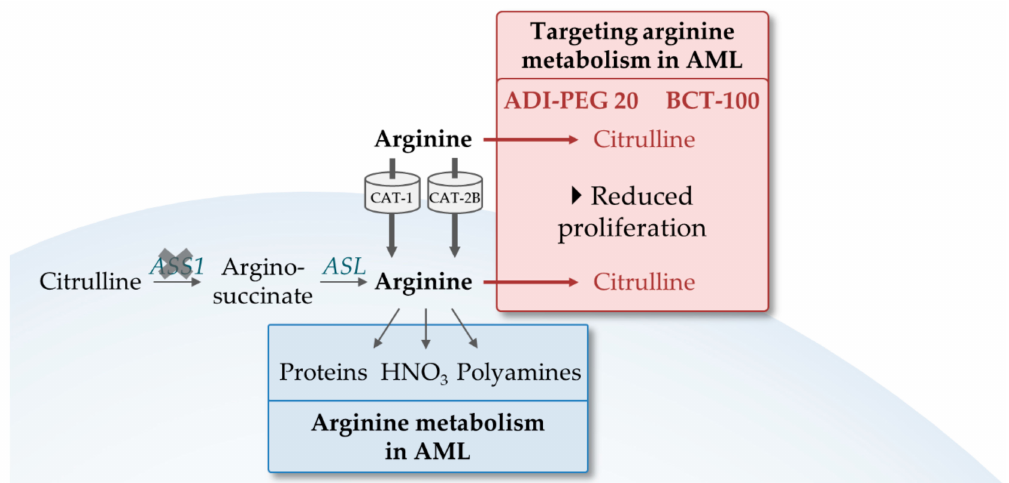
Figure 6. The role of arginine in AML. Arginine is essential in AMLs as the majority lacks argininosuccinate synthetase-1 (ASS1) for de novo synthesis. It is taken up via the transporters CAT-1 and CAT-2B and an important building block for proteins, nitric acid and polyamine synthesis. Upon arginine metabolism inhibition by the arginine deaminases BCT-100 and ADI-PEG 20, cells have a significant reduced proliferation. Red arrows indicate inhibitions by BCT-100 and ADI-PEG 20. Abbreviations: ASL, argininosuccinate lyase; ASS1, argininosuccinate synthetase-1; CAT, cationic amino acid